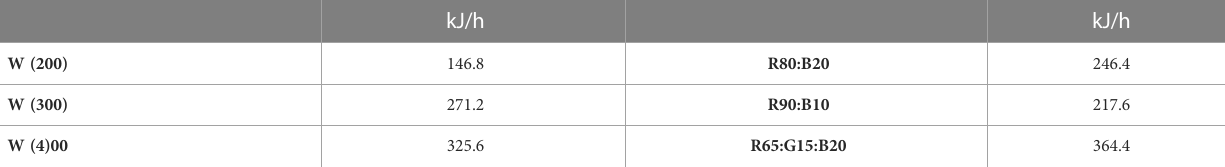
TABLE 5 Energy consumption (kJ/hour) of the different LED illumination regimes, 100% cool white at 200 [W(200)], 300 [W(300)], and 400 [W(400)] m mol m − 2 s − 1 and at 400 m mol m − 2 s − 1 80% Red:20% Blue (R80:B20), 90% Red:10% Blue (R90:B10) and 65% Red:15% Green:20% Blue